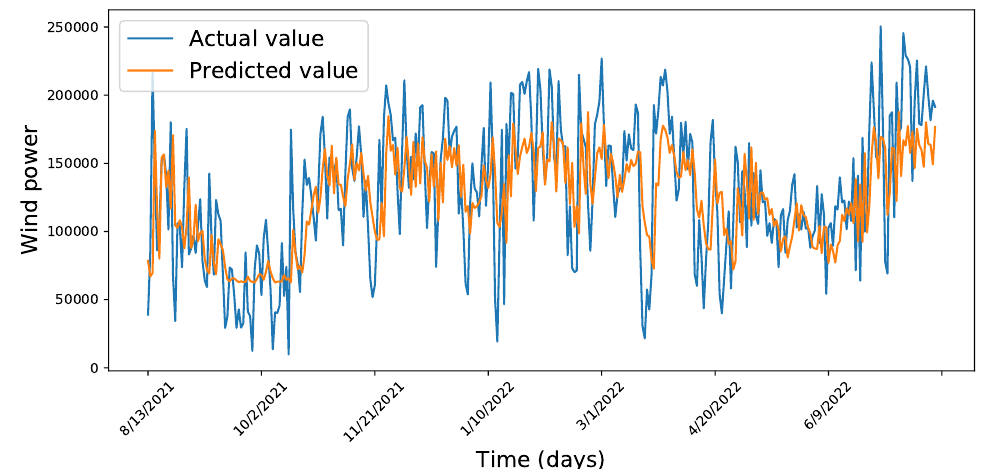
Figure 12. Prediction vs. actual plot for Site